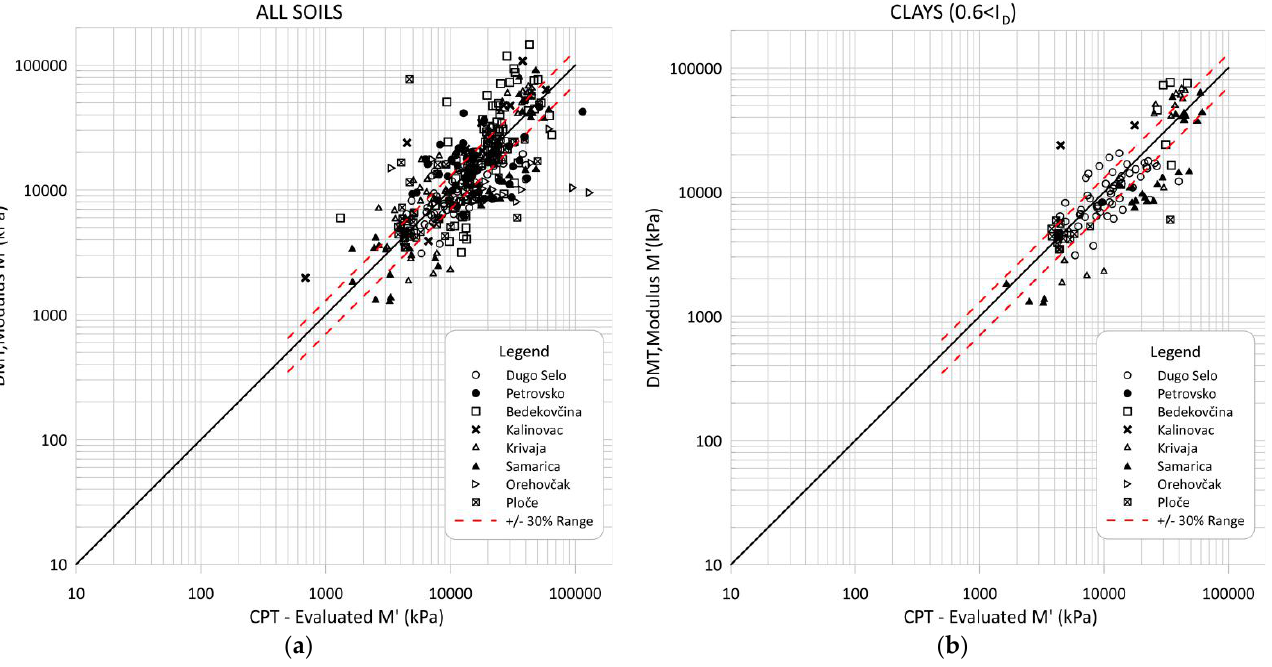
( b ) Figure 16. Comparison of CPT evaluated M′ through correlations and constrained modulus M ′ DMT from dilatometer data: ( a ) for silty mixtures; ( b ) for sandy mixtures.